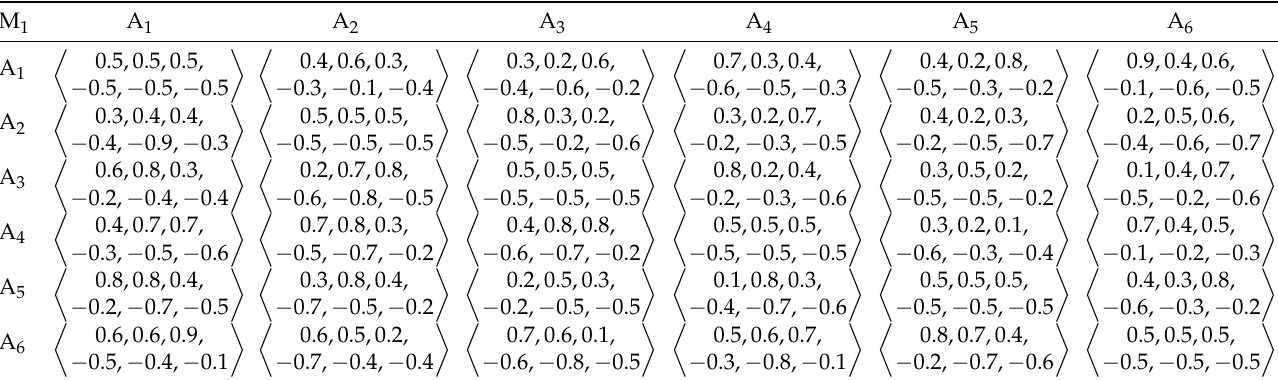
Table 8. BSVNPR of the expert from the operation management department.